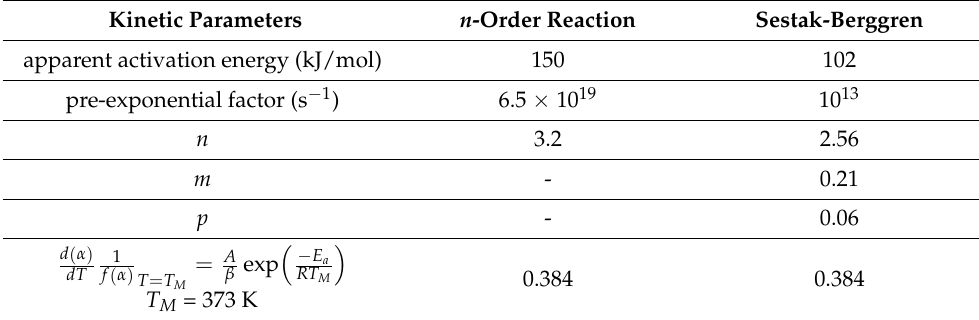
Figure 7. Fitted experimental data ( d α / dT ) and calculated ( d α / dT ) using different reduction models (( a ) n -order reaction, ( b ) Sestak–Berggren, ( c ) n -dimensional nucleation, ( d ) phase boundary-controlled) for the first reduction peak during TPR of 3.5% wt.% IrO 2 /TiO 2 (anatase, BET surface area = 55 m 2 /g) with β = 10 ◦ C/min. Table 3. Estimated values of the kinetic parameter for the first reduction step during TPR of 3.5% wt.% IrO 2 /TiO 2 (anatase, BET = 55 m 2 /g) with β = 10 ◦ C/min. Errors on the activation energy and prefactor taken individually are large, up to 25%. However, taken together, the numbers are exact (as seen in the last row of the table). Errors on n , m , and p are about